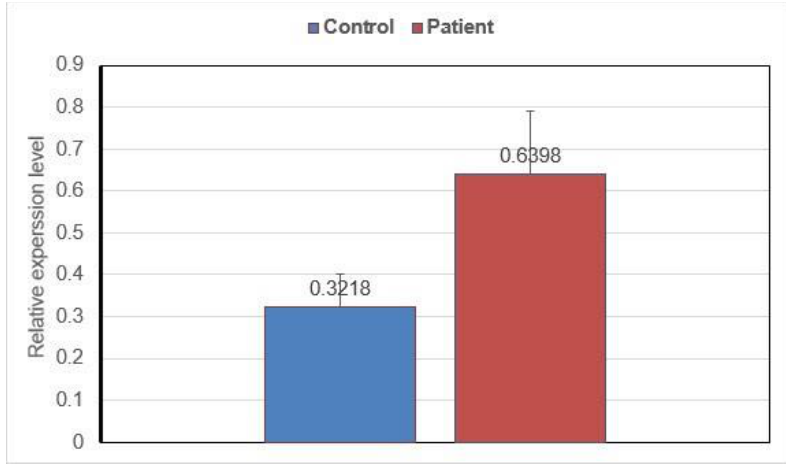
Figure 1. Relative expression of miR-377-3p in healthy and diseased group